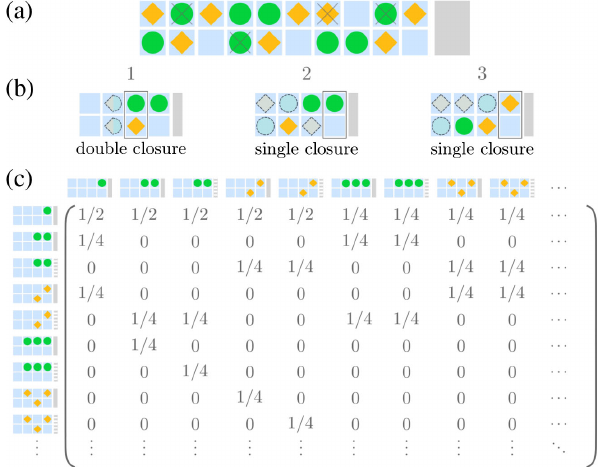
FIG. 11. Illustrations for the filling process, β ¼ 0 , α → 0 . (a) During the filling process, loose particles (crossed particles) are created. Loose particles are particles that can be removed from a jammed configuration without allowing further particle motion. Thus, they are suppressed in any stationary state that exhibits an arbitrary nonvanishing current. (b) If a column is fully occupied (box in group 1), the next particle (shaded particles) cannot pass this column; therefore, a truncation of the state space with respect to particles to the right is possible. This is referred to as double closure. If a linear array of at least two particles of the same species is followed by a particle of the other species, either a double closure is created or a single occupied column can be identified (boxes in groups 2 and 3), beyond which none of the following particles (shaded particles) can pass. This also allows one to truncate configurations to the right of this column, and it is referred to as a single closure. (c) Transition matrix of the stochastic process for β ¼ 0 , α → 0 . The state space reduces to arrays of particles of the same species that follow a double (solid end) or single closure (shaded end). A single particle can only arise after a double closure, as single closures immediately create arrays of length two. In (a) and (b), a gray area denotes the system